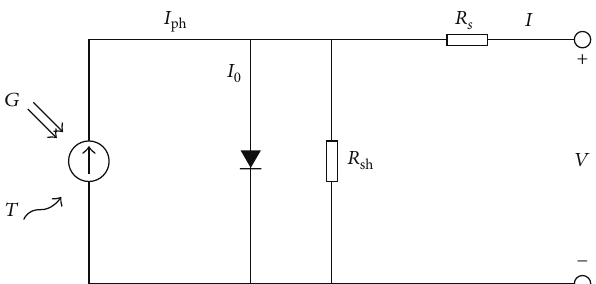
: photocurrent, 𝐼 0 : diode ph : shunt resistance, 𝑇 : sh